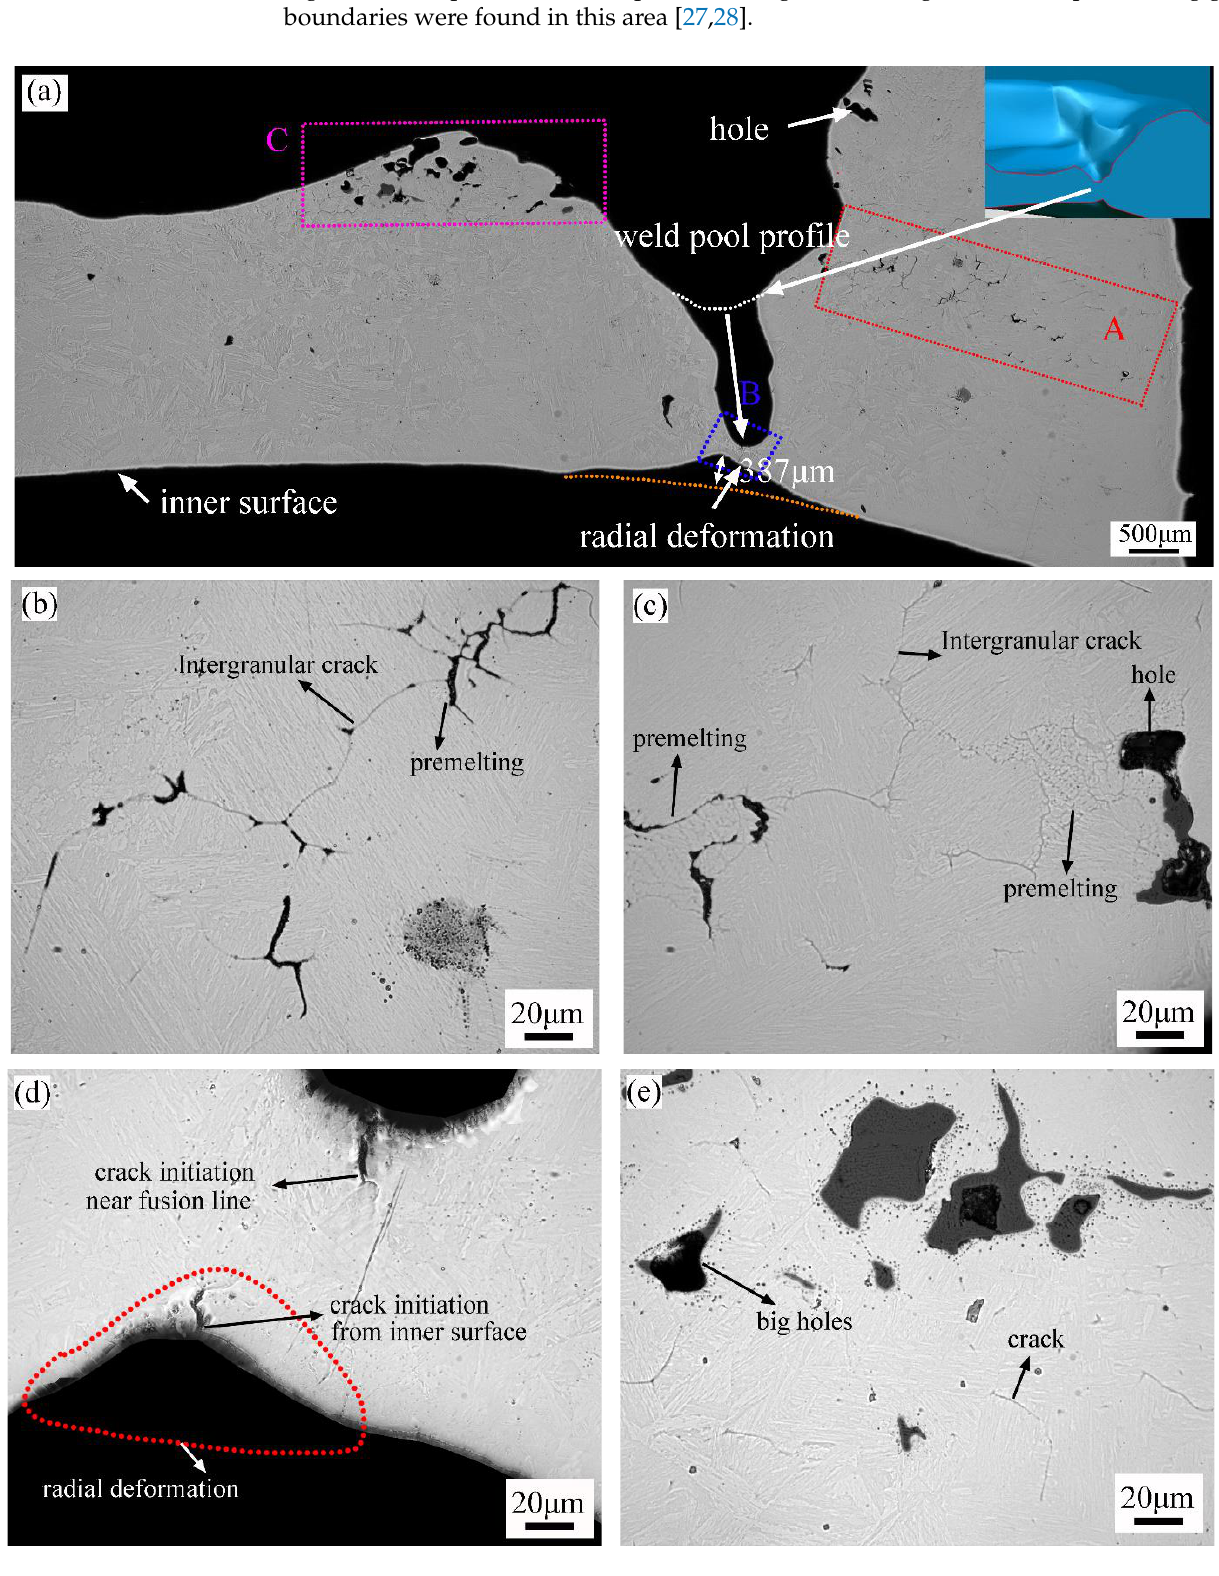
Figure 17. The morphology of the longitudinal section near burn-through hole 1: ( a ) global view of pinhole 1; ( b ) detailed view of location A; ( c ) detailed view of location A; ( d ) detailed view of location B; ( e ) detailed view of location